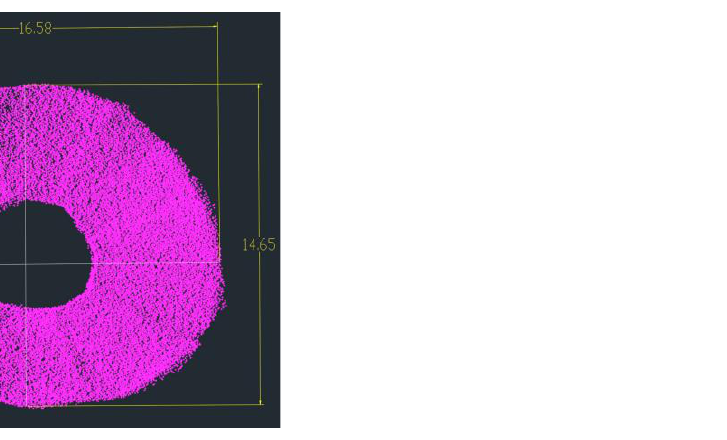
Figure 4. Schematic Dimensions of scour hole in dry scan (all units are in inches) [35,36] (used with permission).